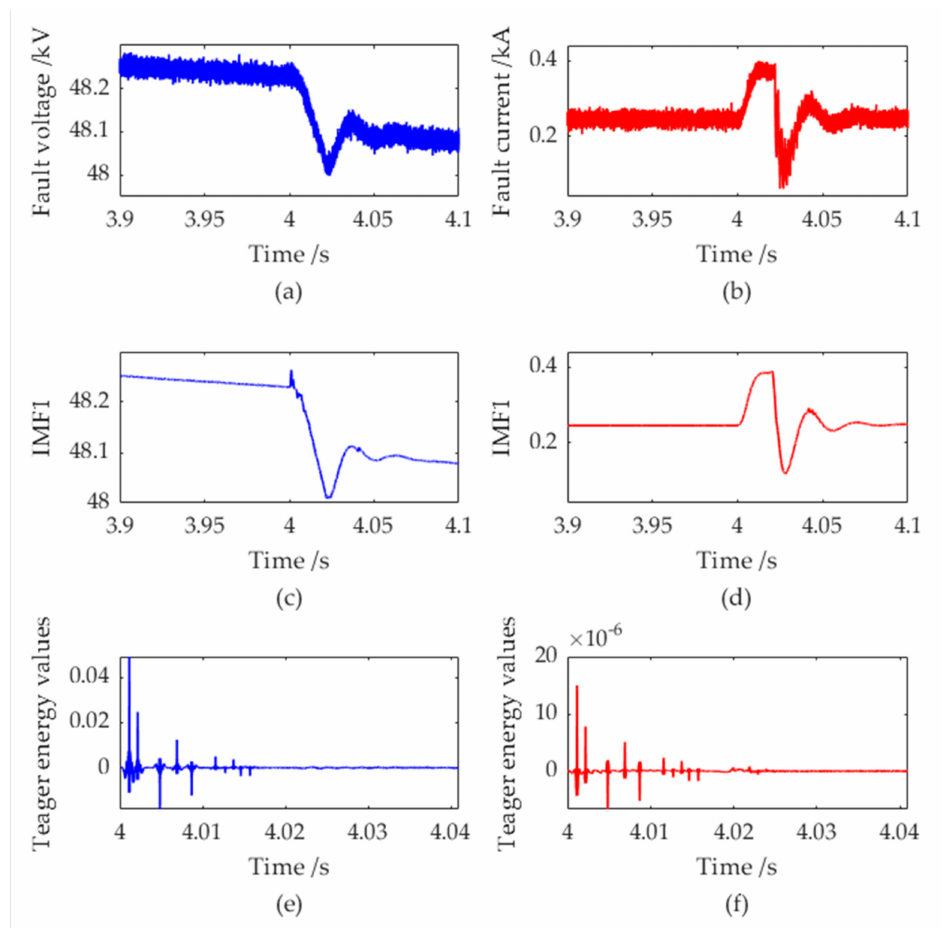
Figure 2. Feature engineering analysis results of negative ground (NG) fault occurring at 350 km; ( a ) fault voltage with noise, ( b ) fault current with noise, ( c ) IMF1 of fault voltage by variational mode decomposition (VMD), ( d ) IMF1 of fault current by VMD, ( e ) Teager energy values (TEVs) of the first intrinsic mode function (IMF1) in fault voltage, and ( f ) TEVs of IMF1 in fault current.